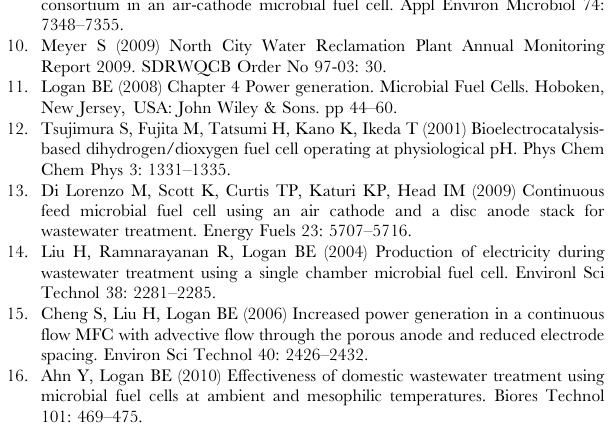
Figure S1 Typical batch cycle of current generation and COD concentrations in the primary clarifier effluent-fed MFC. Thin black line, electric current (mA); Thick red line, accumulated electron production expressed as ‘mM equivalent (eq.)’ calculated as the number of total electrons passing across the circuit from the available COD in solution; solid square blue line, total COD (mg/L) in solution. Figure S2 HPLC chromatographs of wastewater sam- ples before and after MFC treatment. Organic compounds were detected at wavelengths of 210 nm (A, B) or 254 nm (C, D). The untreated primary clarifier effluent chromatographs indicate the presence of several different compounds (A, C), most of which were no longer present in the MFC treated samples (B, D). Figure S3 FE-SEM images for anode biofilms adhering onto carbon cloth anodes (day 152). Bar in panel A is 100 m m, bar in panel B is 10 m m, and bars in panel C and D are 2 m m. Table S1 All phylotypes obtained from the enriched electricity-generating consortia. Table S2 All phylotypes obtained from the primary clarifier